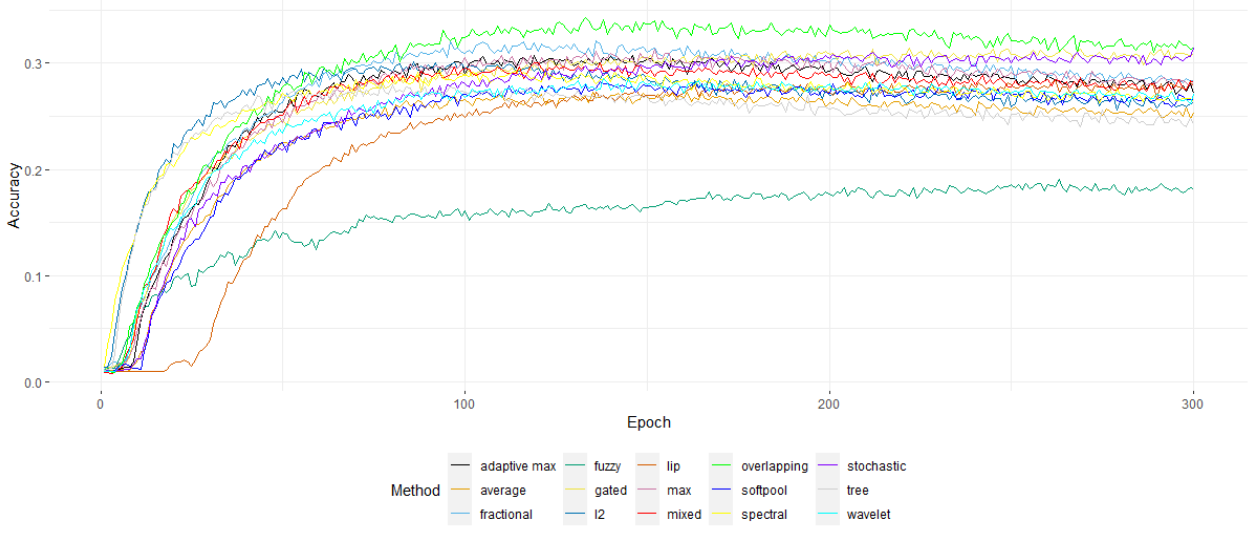
Figure 12. The top 1 accuracy of the models for the CIFAR100 dataset over the